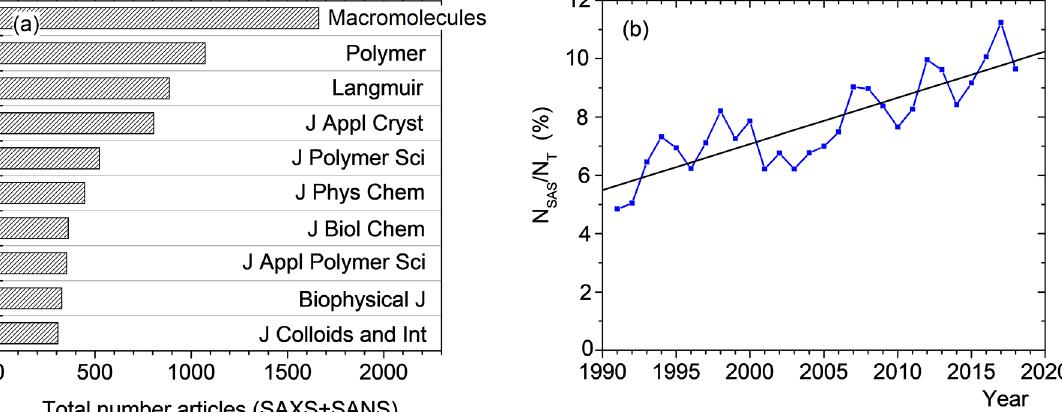
Figure 5. (a) Total number of articles related to SAXS or SANS published by different journals. (b) Historical evolution of the ratio of the number of articles related to SAXS or SANS with respect to the total number of articles published in Macromolecules. The straight line is a guide for the